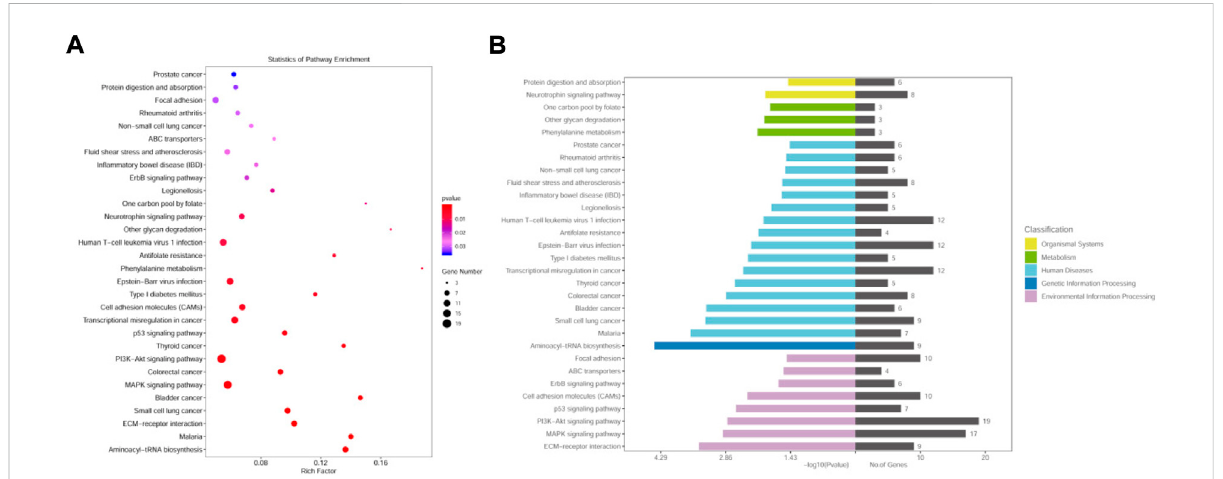
FIGURE 4 KEGGpathwayenrichmentanalysisofDEGs. (A) :DifferentiallyexpressedgeneKEGGpathwaybubble map.Thehorizontalcoordinatesindicate theproportionofenricheddifferentialgenestothebackgroundgenesofthepathway,andtheverticalcoordinatesindicatethenameofthepathway; the size of the dots in the graph indicates the number of enriched differential genes, and the color indicates the p -value. (B) : Distribution of differentially expressed gene KEGG pathway